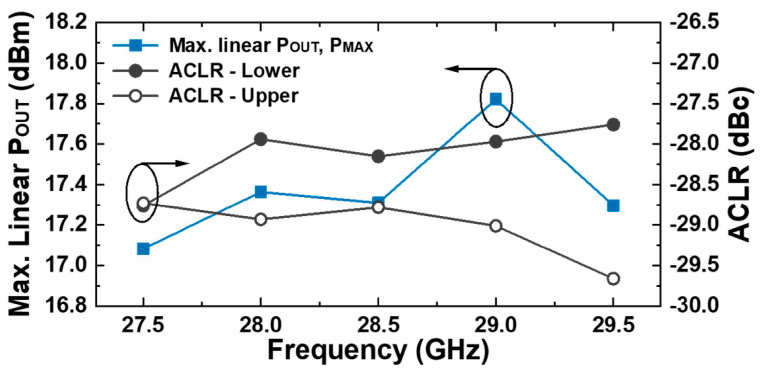
Figure 16. Measurement results with modulation signal (64-QAM, 100 MHz bandwidth, 9.7 dB PAPR): ( a ) EVM and ( b ) ACLR.